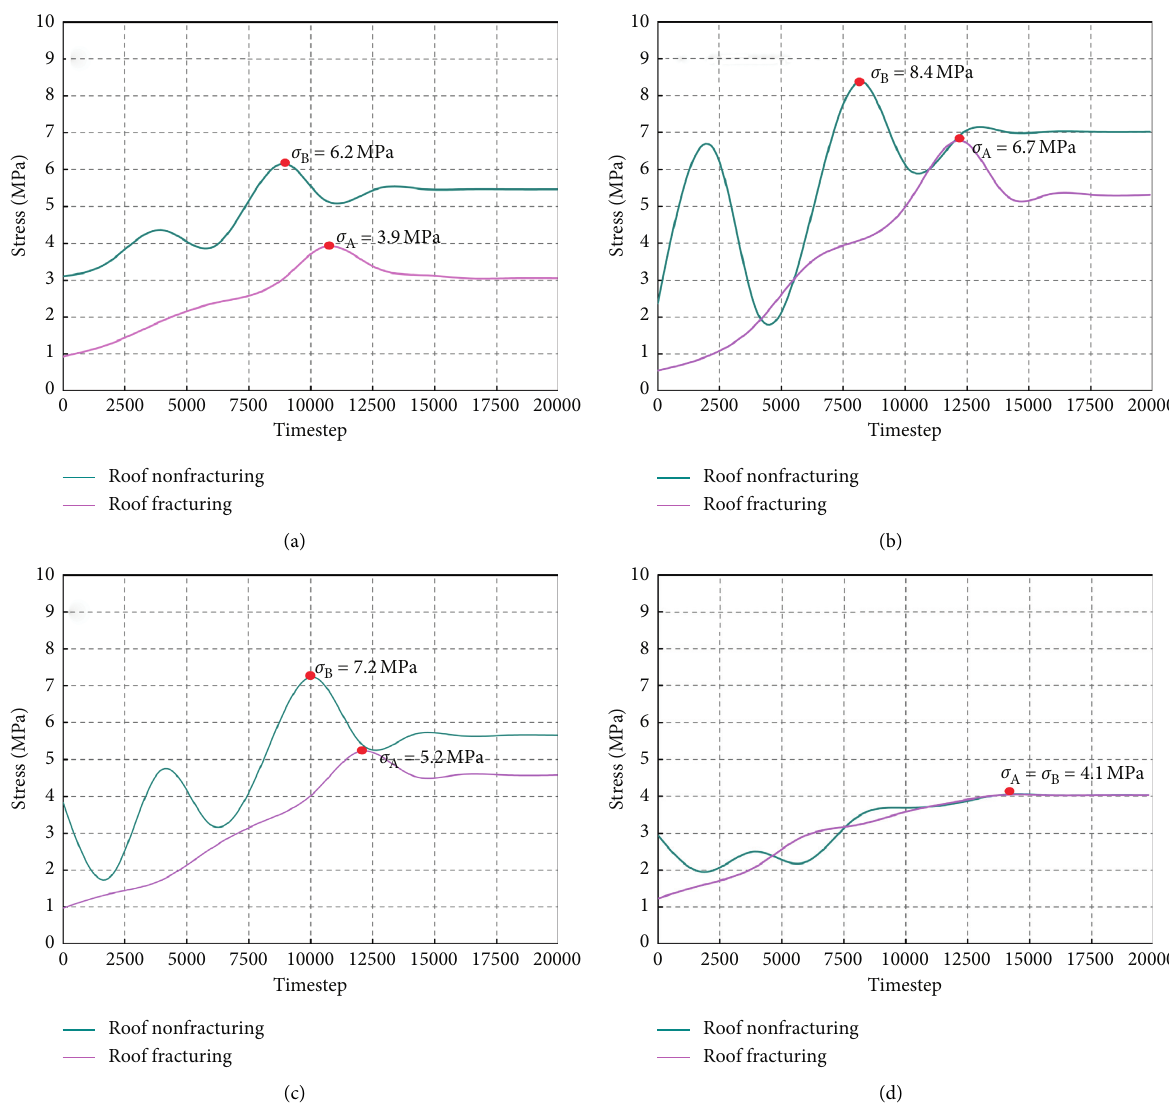
Figure 14: The vertical stress variations at different positions of the roof. (a) 5 m. (b) 10m. (c) 15m. (d)